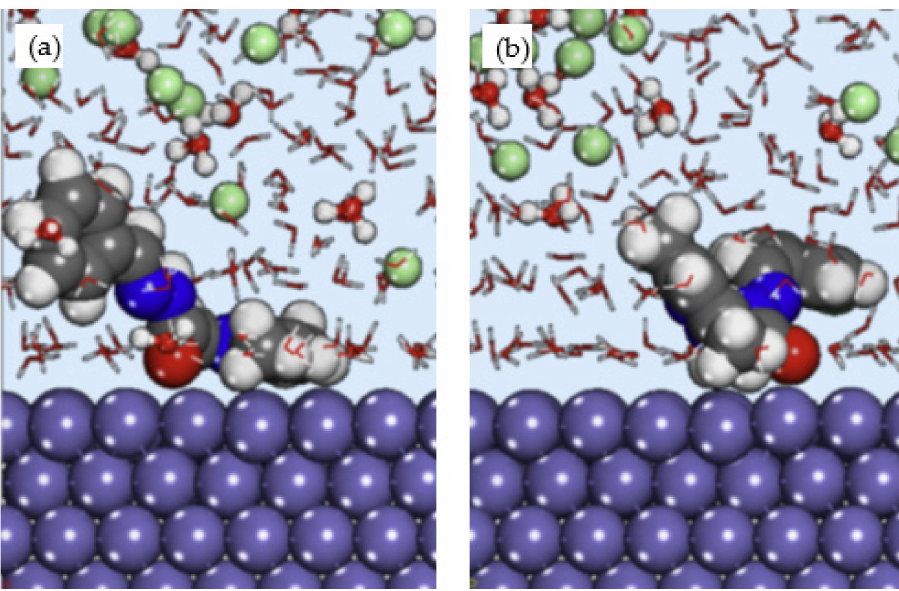
Figure 6. Side view of ( a ) DPP; and ( b ) 4-CP adsorbed on Fe (110) in HCl, reproduced from [41], with permission from Elsevier,